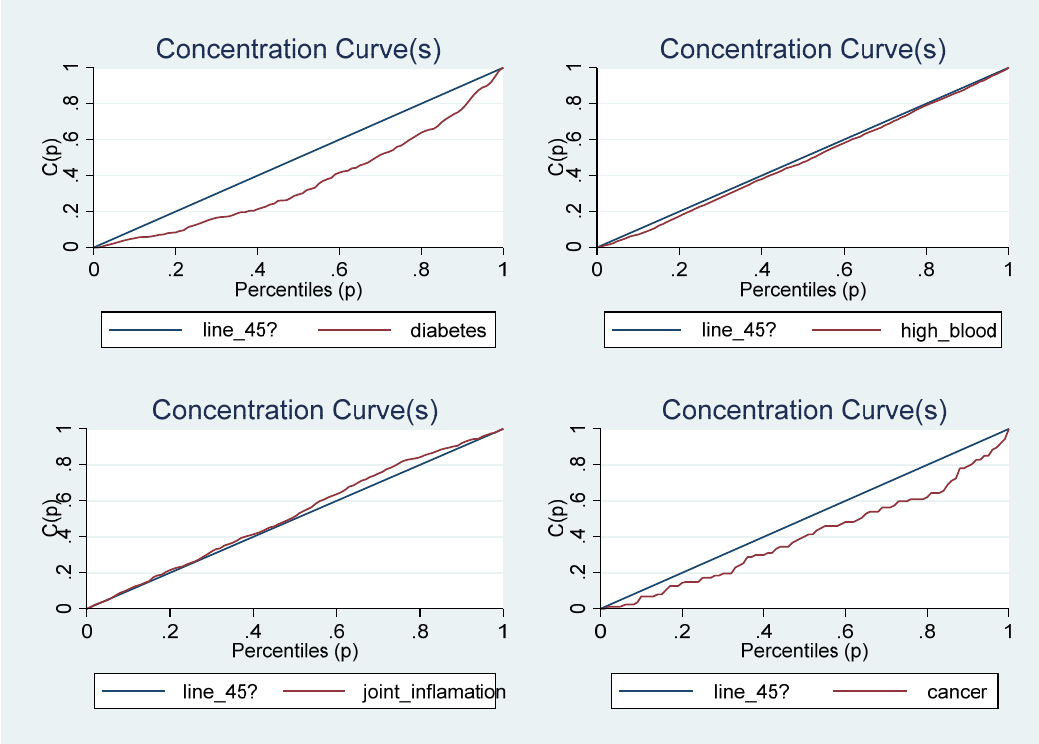
Figure 2. The Concentration Curves for some tobacco/alcohol ‐ related chronic diseases.